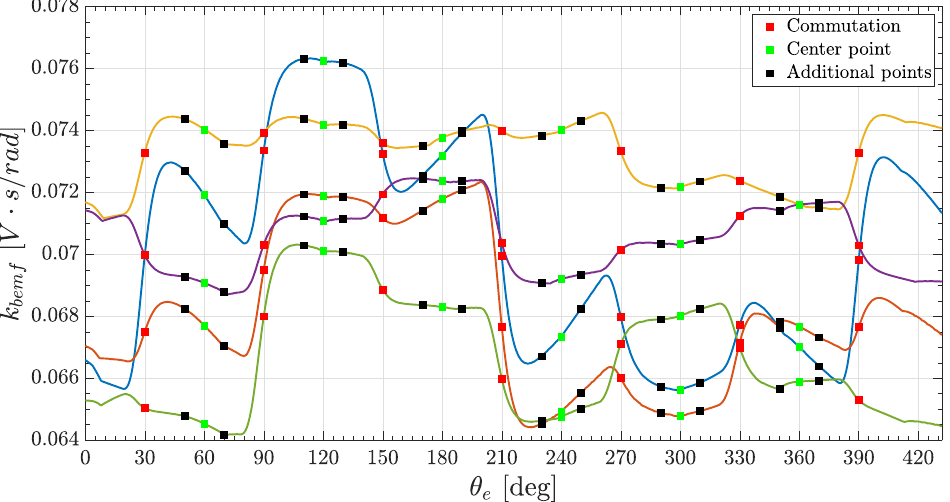
Figure 7. Discretization of five randomly seeded reconstructed back-EMF coefficient